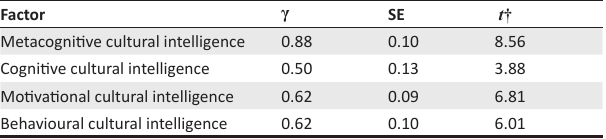
TABLE 5: Dimension intercorrelations between second-order cultural intelligence and first-order factors (unstandardised gamma matrix). Factor γ SE